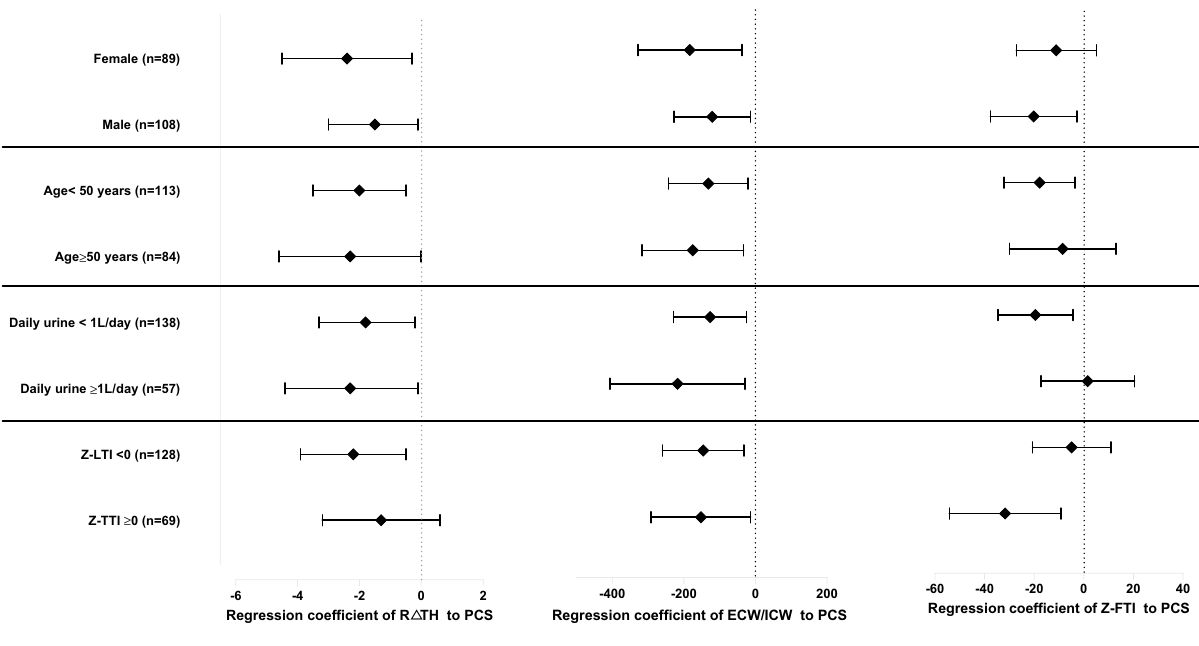
Figure 1. Plot of regression coefficients for the association between PCS and R∆TH, ECW/ICW, and Z-FTI. Error bars indicate 95% confidence intervals. R∆TH Relative ∆tissue hydration, ECW extracellular water, ICW intracellular water, Z-FTI Z-score of fat tissue index, Z-LTI Z-score of lean tissue index, PCS physical component